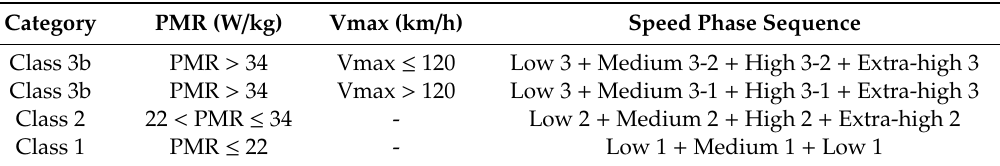
Table 6. WLTC test cycles.